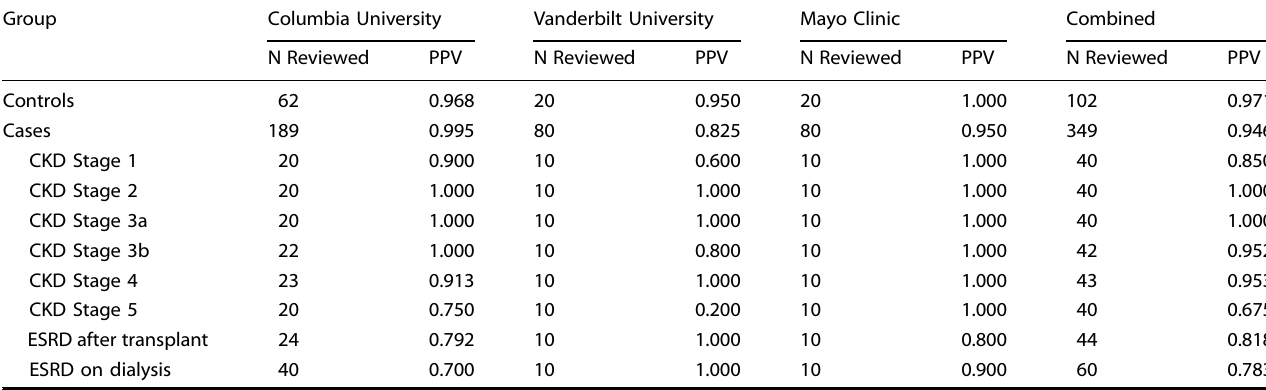
Table 2. Manual validation of the CKD diagnosis and staging algorithm.